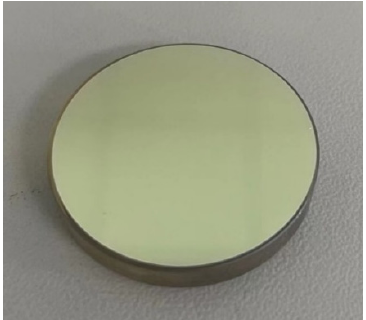
Figure 3. The superpolished sample with reflective silver-enhanced coating.